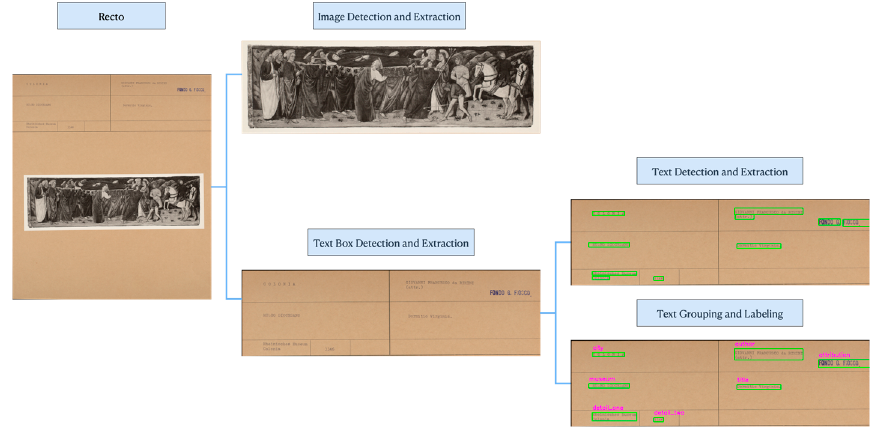
Figure 8. Schema of Cardboard’s element extraction .